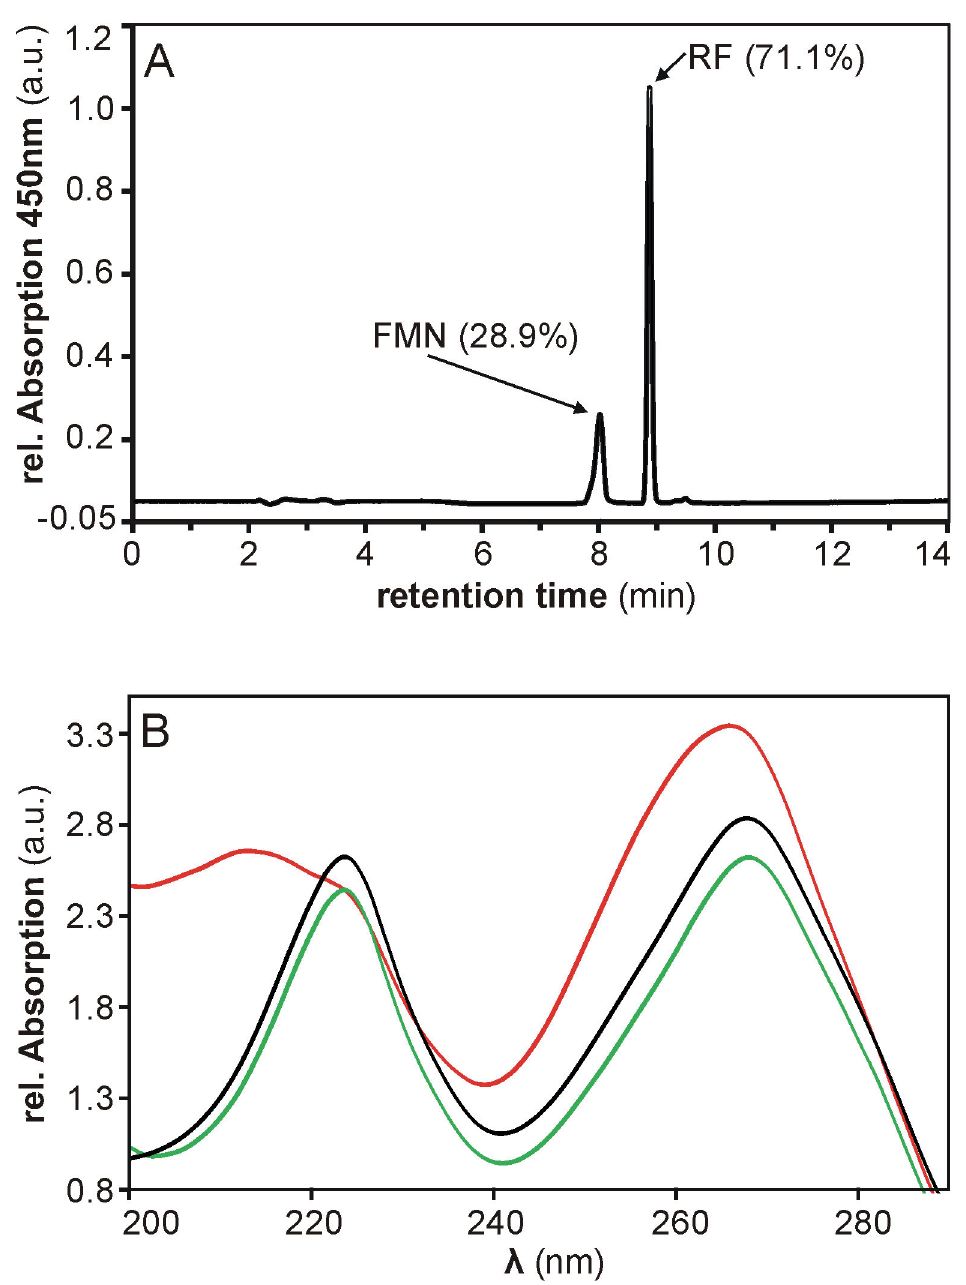
Figure 7. HPLC-based analysis of flavins isolated from B. subtilis cell lysate. (A) By means of reverse-phase HPLC, flavins isolated from B. subtilis cell lysate using His-tagged Apo-YLOV as a molecular probe were identified as RF and FMN. The corresponding peaks are labeled by type of flavin and its relative amount. (B) Comparison of UV-Vis spectra measured at the respective peak maxima of FMN from B. subtilis (black line) and FMN (green line) and FAD (red line) from reference samples indicates that the faster eluting flavin species isolated from B. subtilis is indeed FMN. doi: 10.1371/journal.pone.0081268.g007 the terminal phosphate of FMN might not be necessary for small differences in chromophore surrounding regions. binding. Comparison of 1 H, 15 N-TROSY spectra of the Absence of the phosphate group most likely changes the reconstituted proteins indicated that variants containing RF or hydrogen bonding network within the binding pocket which FMN adopt virtually the same global structure with only very explains the accelerated dark-state recovery of RF-YtvA and